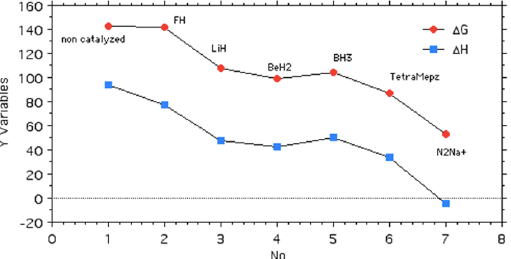
Figure 3. Energy profiles [Y Variables, Δ G (red) and Δ H (blue)] in kJ·mol − 1 corresponding to the barriers shown in Table 2.